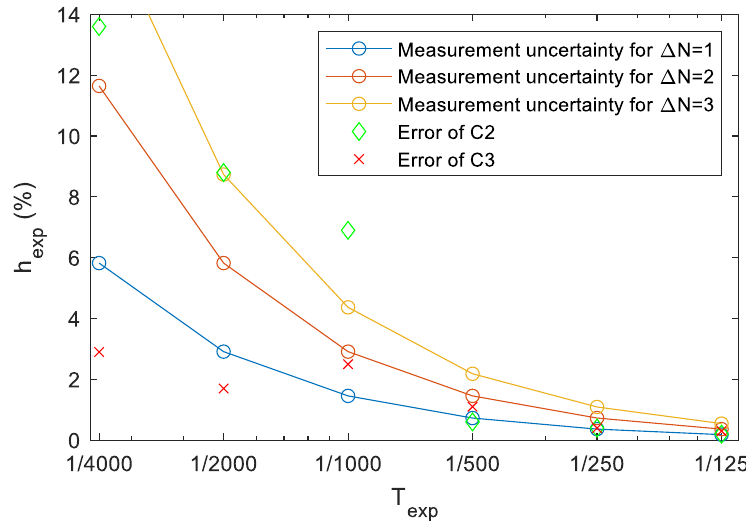
Figure 12. Maximum theoretical relative uncertainty of the exposure time estimates of the monitor measurement. Measurement errors of C2 and C3, using the unbiased estimate of (11), are also shown. An example measurement of C2 is shown in Figure 13, with exposure time of 1/500 sec.